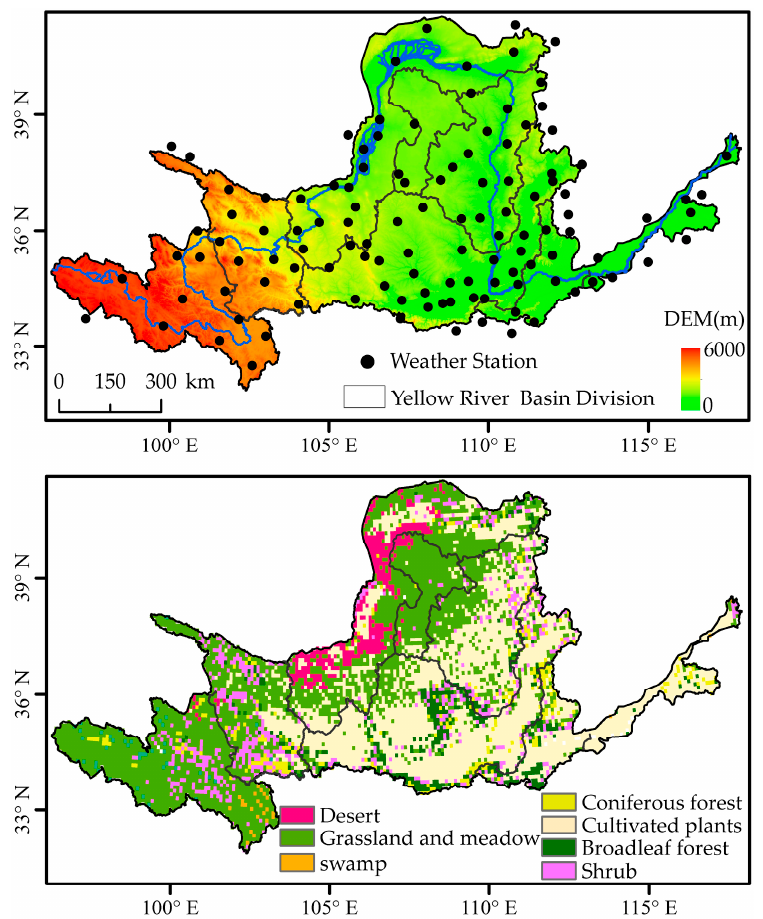
Figure 1. The altitude, weather stations, and vegetation types in the Yellow River Basin.